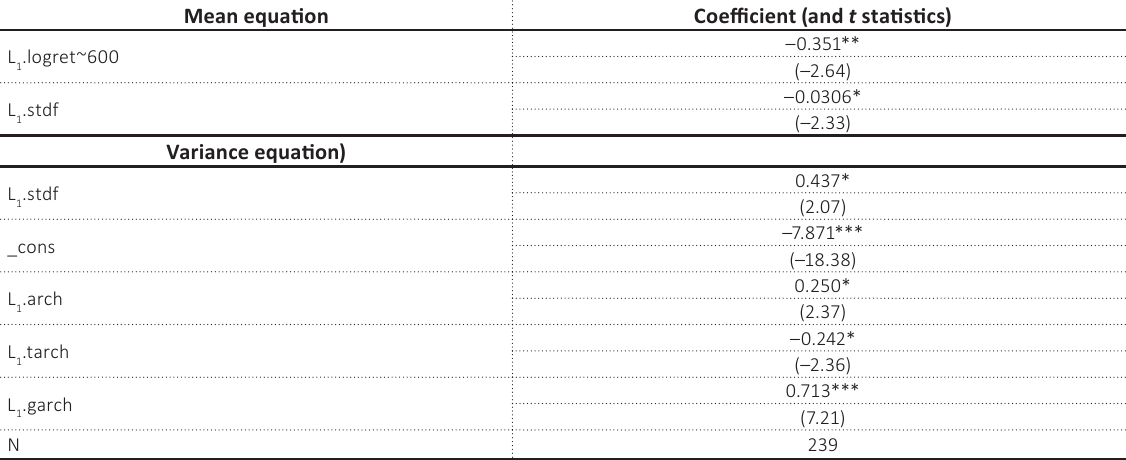
Table 2. TGARCH model for log of Stoxx600 return and